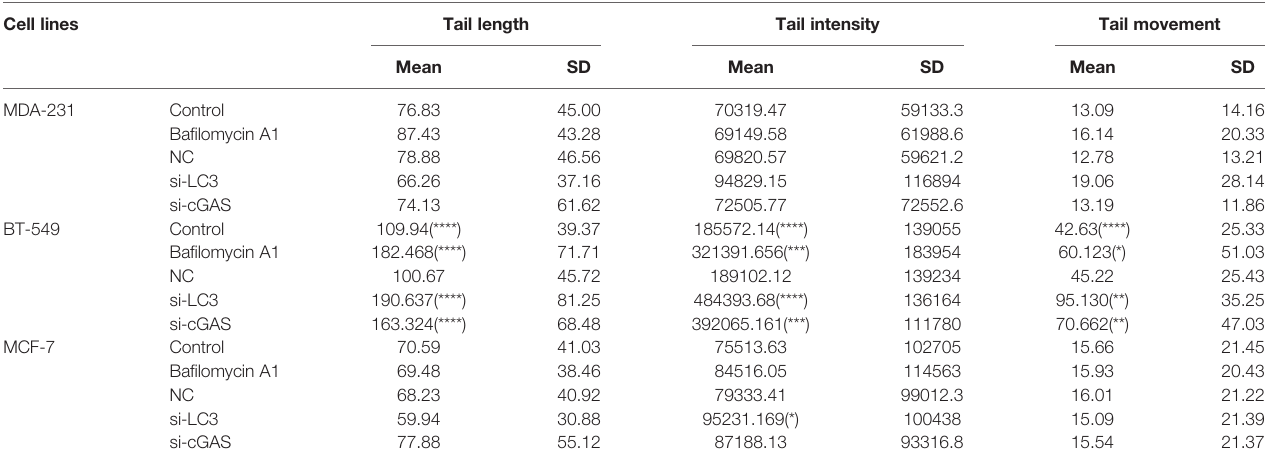
TABLE 1 | The results of the Comet assay. Cell